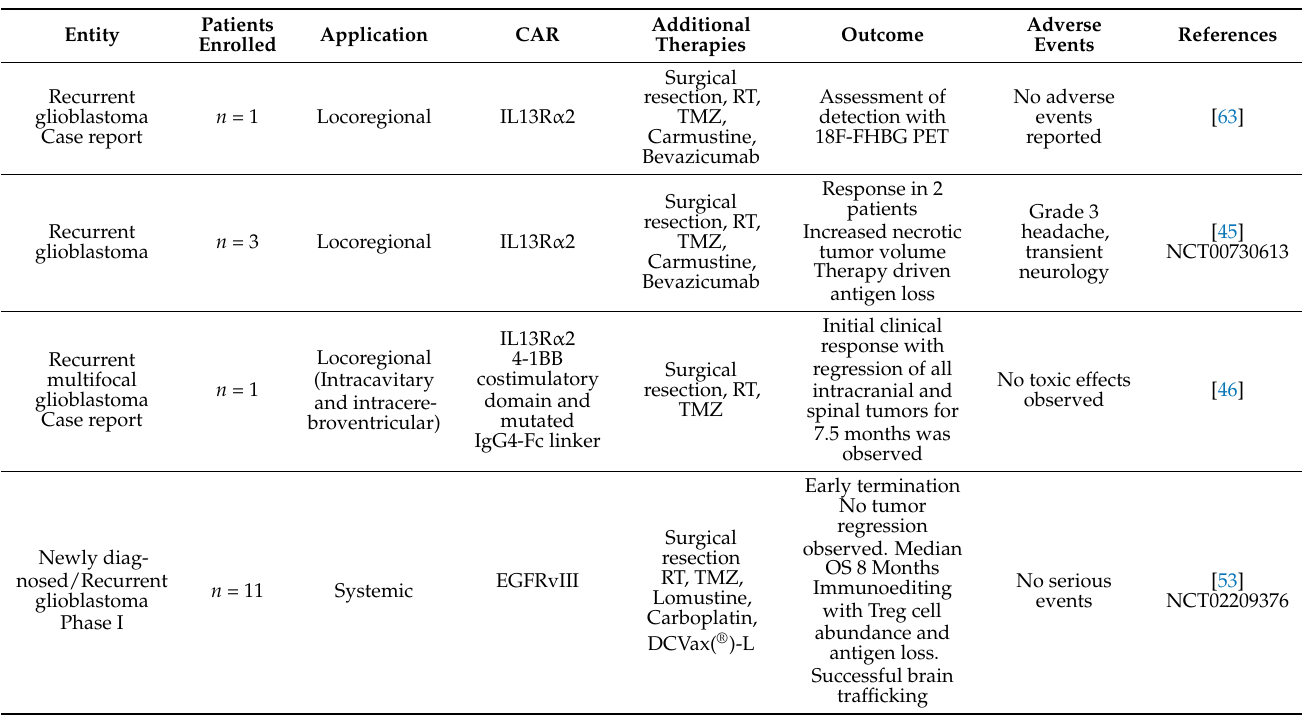
Table 1. Published studies involving CAR-T cell therapies in malignant